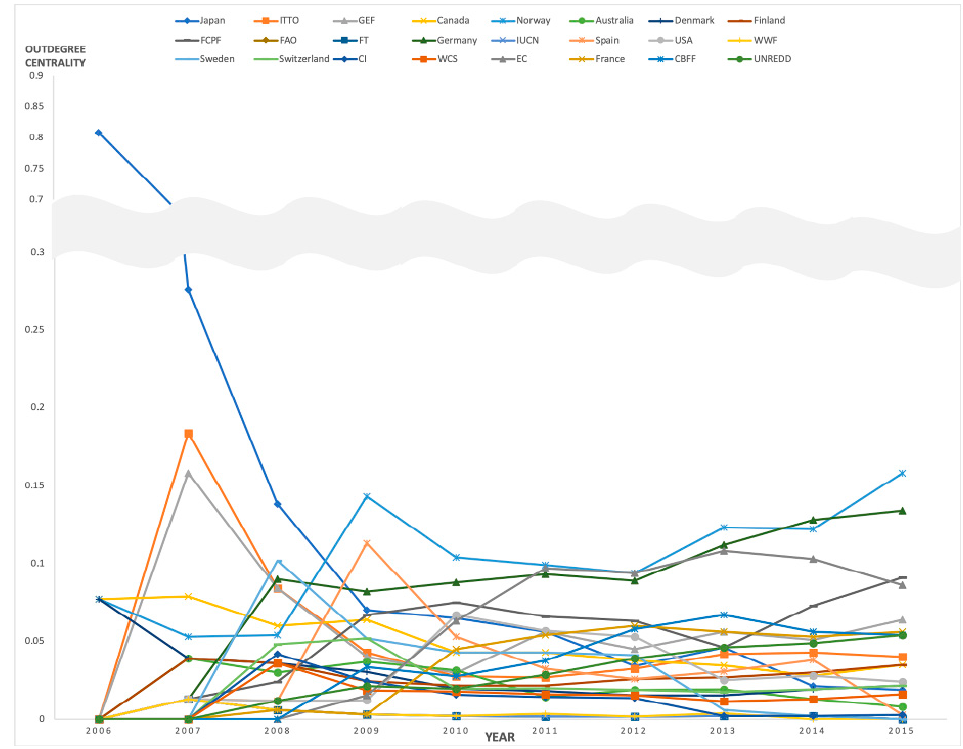
Figure 8. Annual changes in out-degree centrality of major donors between 2006 and 2015 (y-axis break between 0.3 and 0.7 was applied to improve visualization). (IUCN: International Union for Conservation of Nature, WWF: World Wildlife Fund, CI: Conservation International, WCS: Wildlife Conservation Society, CBFF: Congo Basin Forest